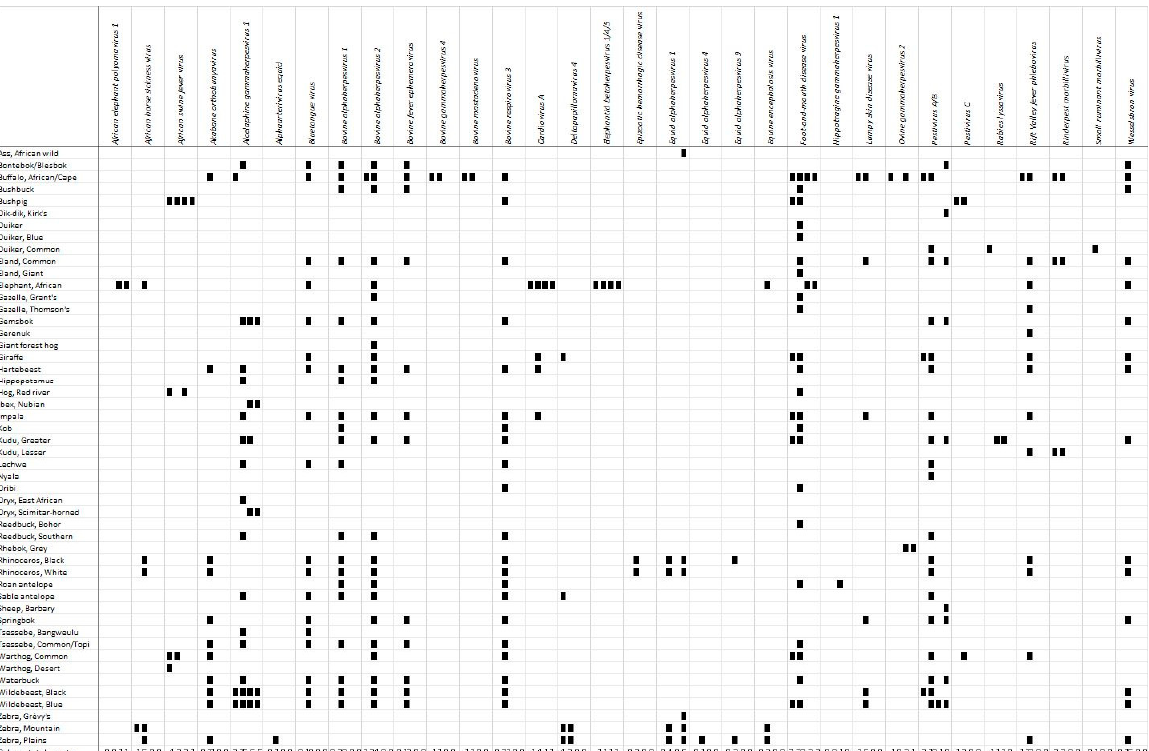
Figure 3. Detection of viral antigen/antibodies in free-ranging and captive African ungulates. The ungulate species are listed in the left-hand column and the pathogens (viruses) are listed in the first row. A black rectangle in the furthest left position within the cell indicates that the pathogen has been detected in a free-ranging member of that ungulate species. For example, Alcelaphine gammaherpesvirus 1 antigen has only been detected in free-ranging African buffalo. A black rectangle in the centre left position within the cell indicates that antibodies to the pathogen have been detected in a free-ranging member of that ungulate species. For example, Alcelaphine gammaherpesvirus 1 antibodies have only been detected in free-ranging Blesbok/Bontebok. A black rectangle in the centre right position within the cell indicates that antibodies to the pathogen have been detected in a captive member of that ungulate species. A black rectangle in the furthest right position within the cell indicates that the pathogen has been detected in a captive member of that ungulate species. For example, African elephant polyomavirus 1 antigen and antibodies have been detected only in captive African elephants. These are not quantitative data about pathogens or antibodies to pathogens detected in ungulates but rather indicate whether a particular pathogen or antibodies to the pathogen have been detected in a specific ungulate species or not.